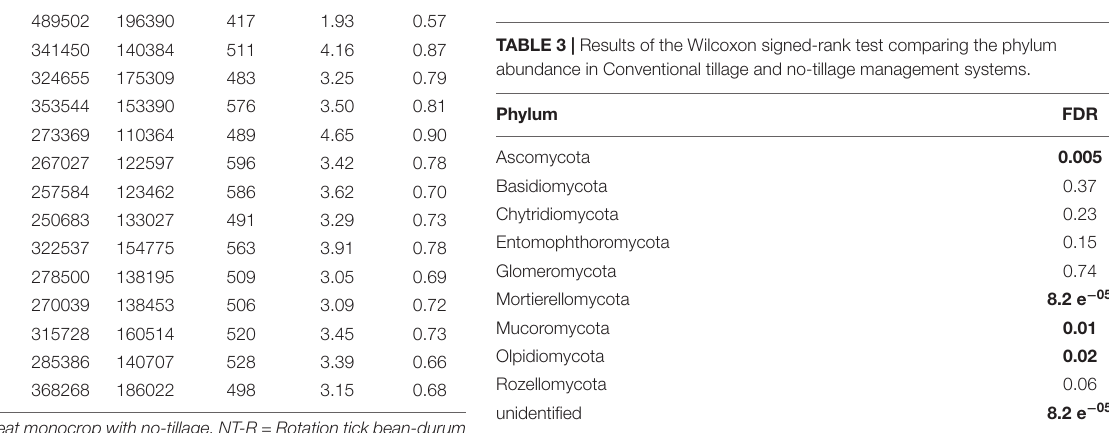
TABLE 2 | Summary of sequence data generated in this study and diversity estimate for each sample. Sample